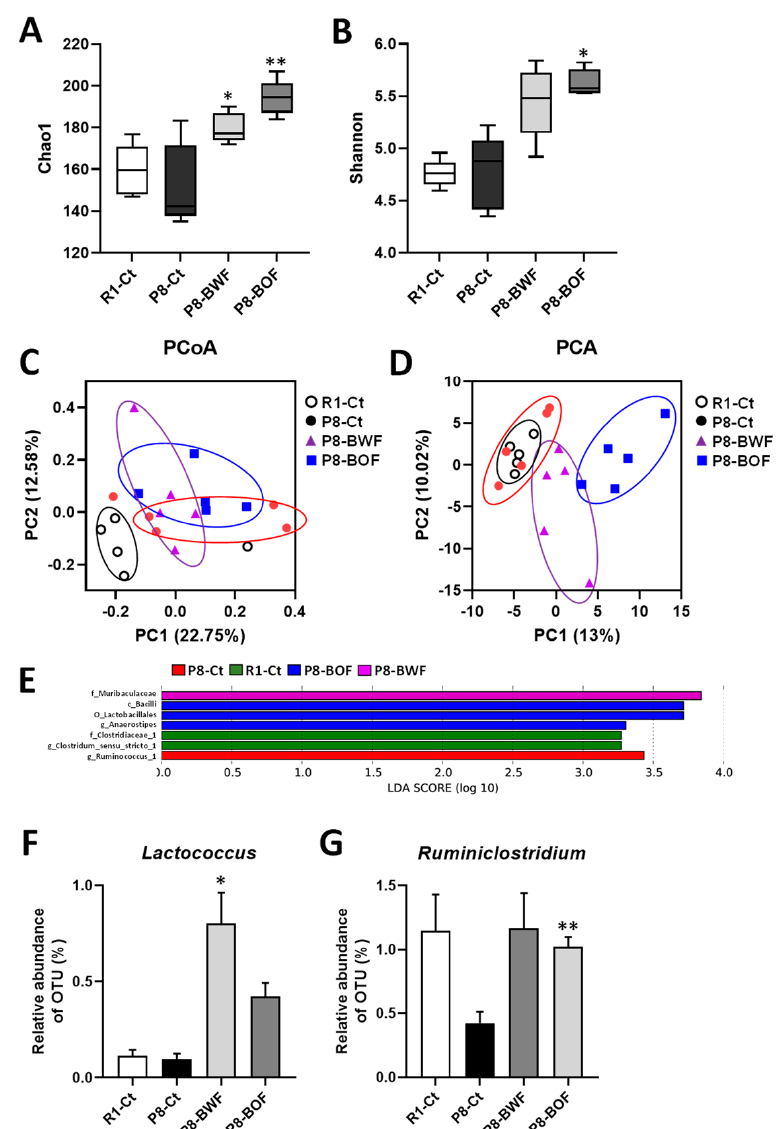
Figure 2. Effects of oral administration of buckwheat flours on the gut microbiota in SAMP8. ( A , B ) α - Diversity of flora in the cecal contents. ( C , D ) β -Diversity of flora in the cecal contents. ( E ) Results of the LEfSe analysis (LDA > 3.0). ( F , G ) Effects on Lactococcus and Ruminiclostridium abundances. Data are presented as the mean ± standard error of mean ( n = 5). * p < 0.05, ** p < 0.01 vs. the P8-Ct group. LEfSe, linear discriminant analysis Effect Size; LDA, linear discriminant analysis; OTU, operational taxonomic